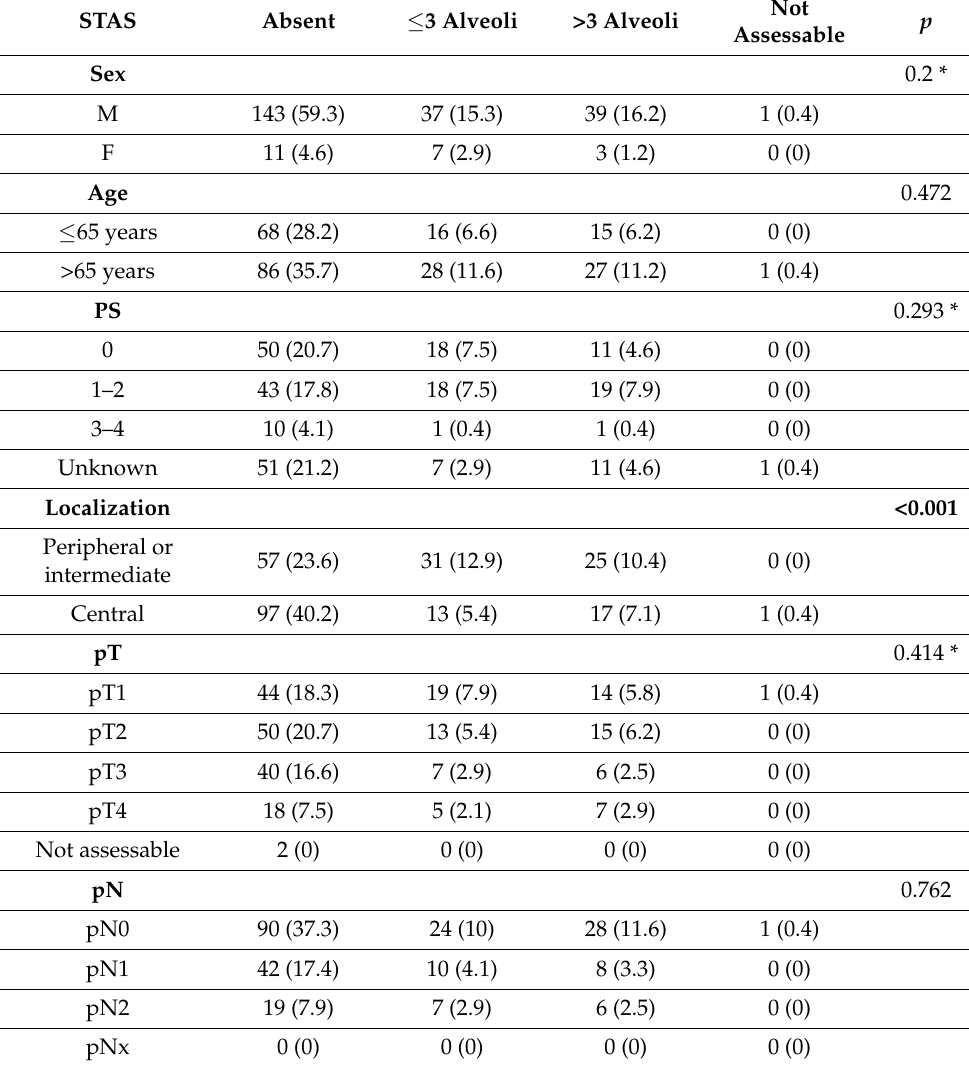
Not p Assessable